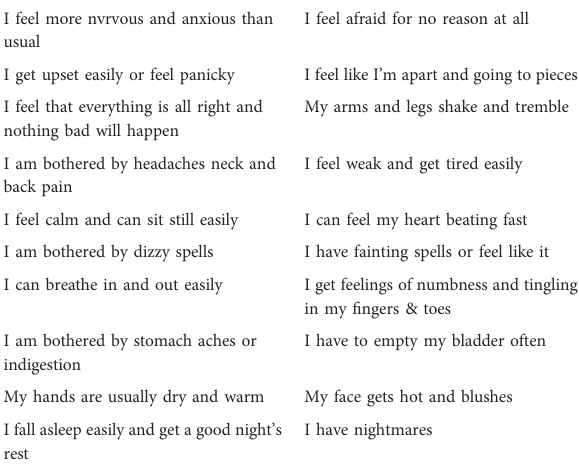
TABLE 2 Anxiety scale ( (cid:1) x + s , n =7